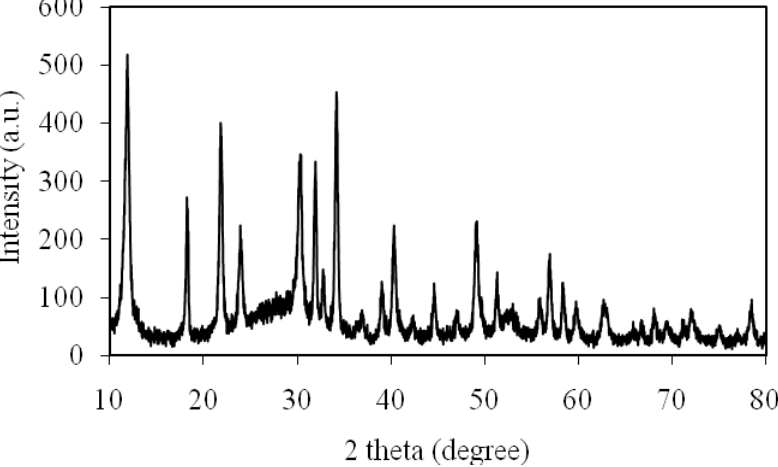
powder (after catalytic 3